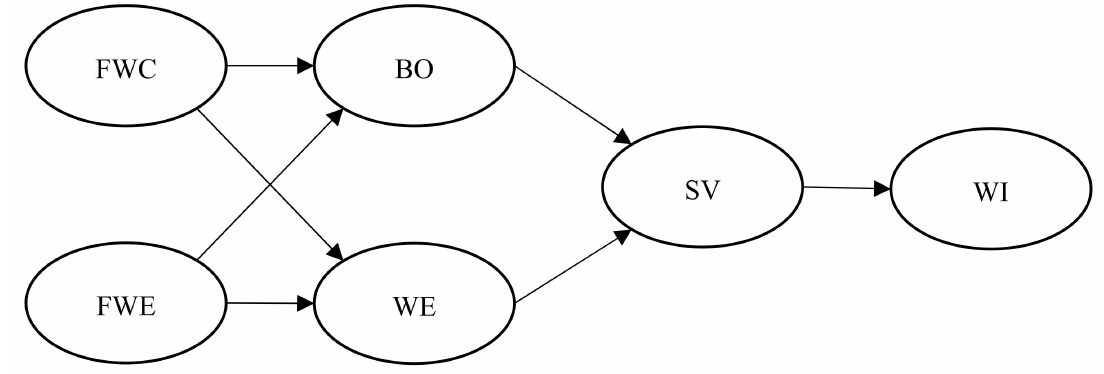
Figure 1. The theoretical model. FWC = family-to-work conflict; FWE = family-to-work enrichment; BO = burnout; WE = work engagement; SV = safety violations; WI = workplace